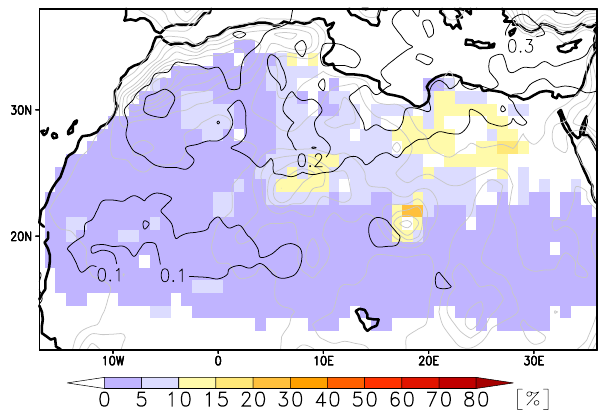
Figure 12. Annual fraction of dust emission amount associated with long-lived and migrating cyclones. Shown is the fraction of total dust emission associated with cyclones in percent averaged for 1989–2008 (shaded). Dust emission within a radius of 10 ◦ from the cyclone centre is considered (see Sect. 2). Black contours show the annually averaged occurrence frequency of cyclones in steps of 0.1 percent. Grey contours show the orography in steps of 200m.